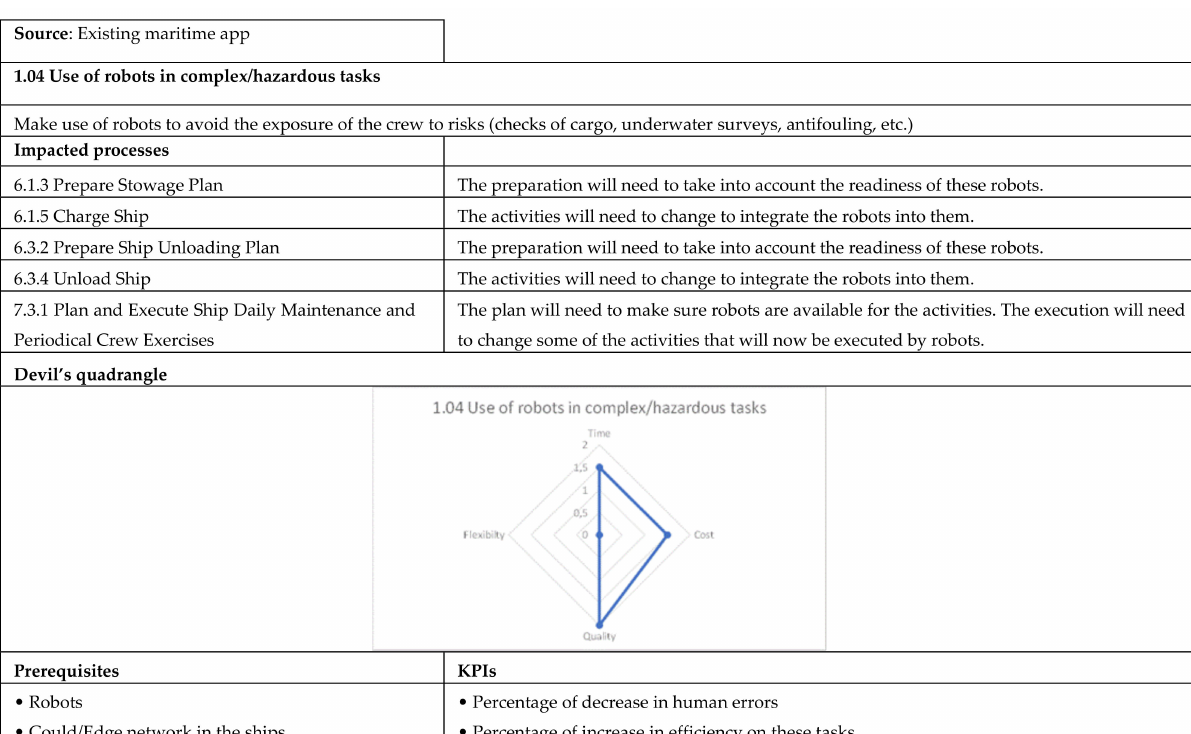
Figure A4. Use of robots in complex/hazardous tasks data